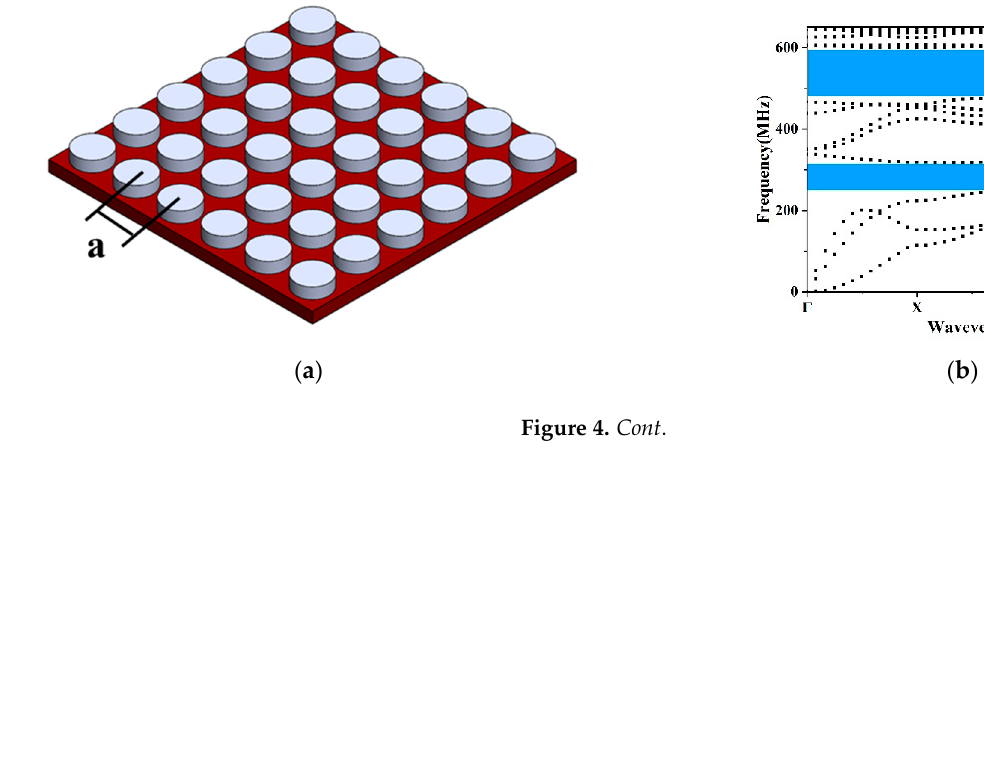
Figure 3. Dispersion relations of PnC slabs with ( a ) Al, ( b ) Mo, ( c ) Ag and ( d ) Pt pillars. Lattice types have strong influences on the acoustic bandgap [26,31,32]. Square lattice, hexagonal lattice and honeycomb lattice are frequently accepted as the shapes of the primitive cell. The three mentioned structures have the same lattice constant a = 4 μ m, diameter of pillar d = 3 μ m, height of pillar h = 1 μ m and the pillar material Pt. To compare phononic bandgaps in three different lattice types, the first 20th dispersion curves were calculated. Figure 4a–c depict the schematics for the integration of the unit cell shaped in square, hexagon and honeycomb in a standard platform. Each shape presents great potentials in filling a regular plane. Figure 4d–f illustrate the irreducible part of the Brillouin zone and the phononic band structure of different lattice types. The widest bandgap of the honeycomb lattice exists in the 490–589 MHz. The widest bandgap of the hexagonal lattice locates at 485–595 MHz. Accordingly, square lattice provides superior properties compared to hexagonal lattice and honeycomb lattice in pillar-based PnC design. The wide complete acoustic bandgaps in UHF and very high frequency (VHF) ranges in Figure 4d can efficiently prevent elastic wave propagation and remarkably expand the vibration attenuation range.